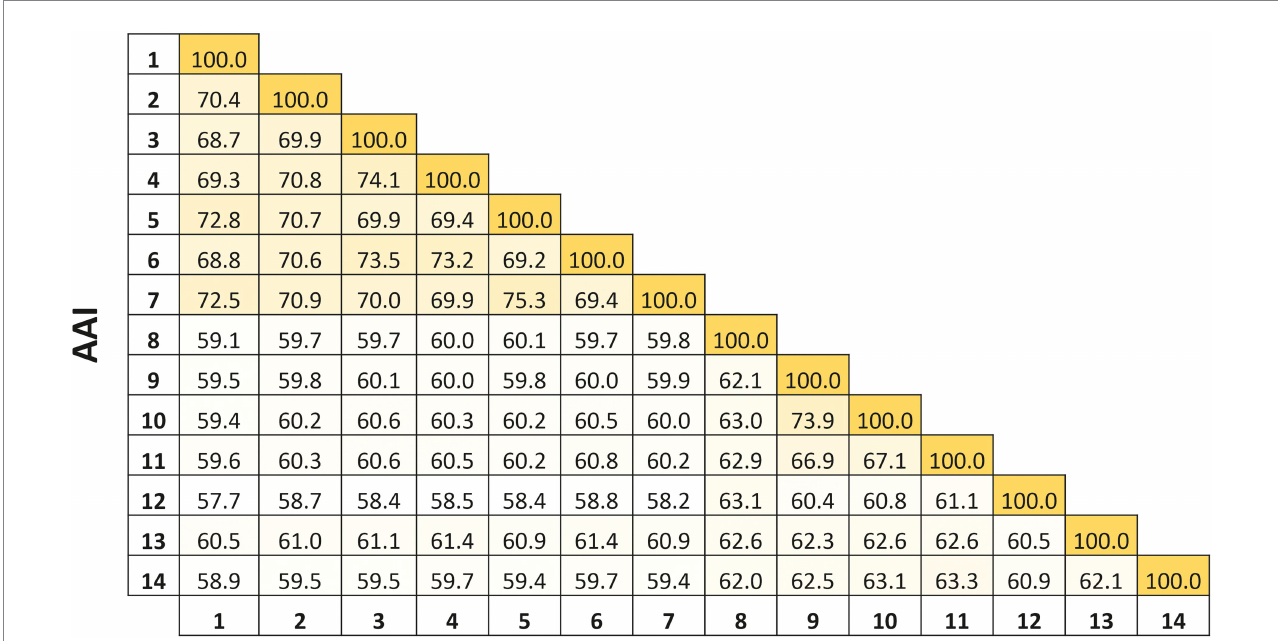
FIGURE 2 Average Amino acid Identity (AAI) percentages among the species of the genus Natronomonas , including strain F2-12 T , and other related haloarchaeal genera. Strains: 1, Natronomonas aquatica F2-12 T (GCA_024449025.1); 2, Natronomonas pharaonis DSM 2160 T (GCA_000026045.1); 3, Natronomonas gomsonensis JCM 17867 T (GCA_013391635.1); 4, Natronomonas halophila C90 T (GCA_013391085.1); 5, Natronomonas moolapensis 8.8.11 T (GCA_000591055.1); 6, Natronomonas salina YPL13 T (GCA_013391105.1); 7; Natronomonas salsuginis F20-122 T (GCA_005239135.1); 8, Halapricum salinum CBA1105 T (GCA_004799665.1); 9, Haloarcula vallismortis ATCC 29715 T (GCA_000337775.1); 10, Halomicroarcula pellucida JCM 17820 T (GCA_014647235.1); 11, Halomicrobium mukohataei DSM 12286 T (GCA_000023965.1); 12, Halorhabdus utahensis DSM 12940 T